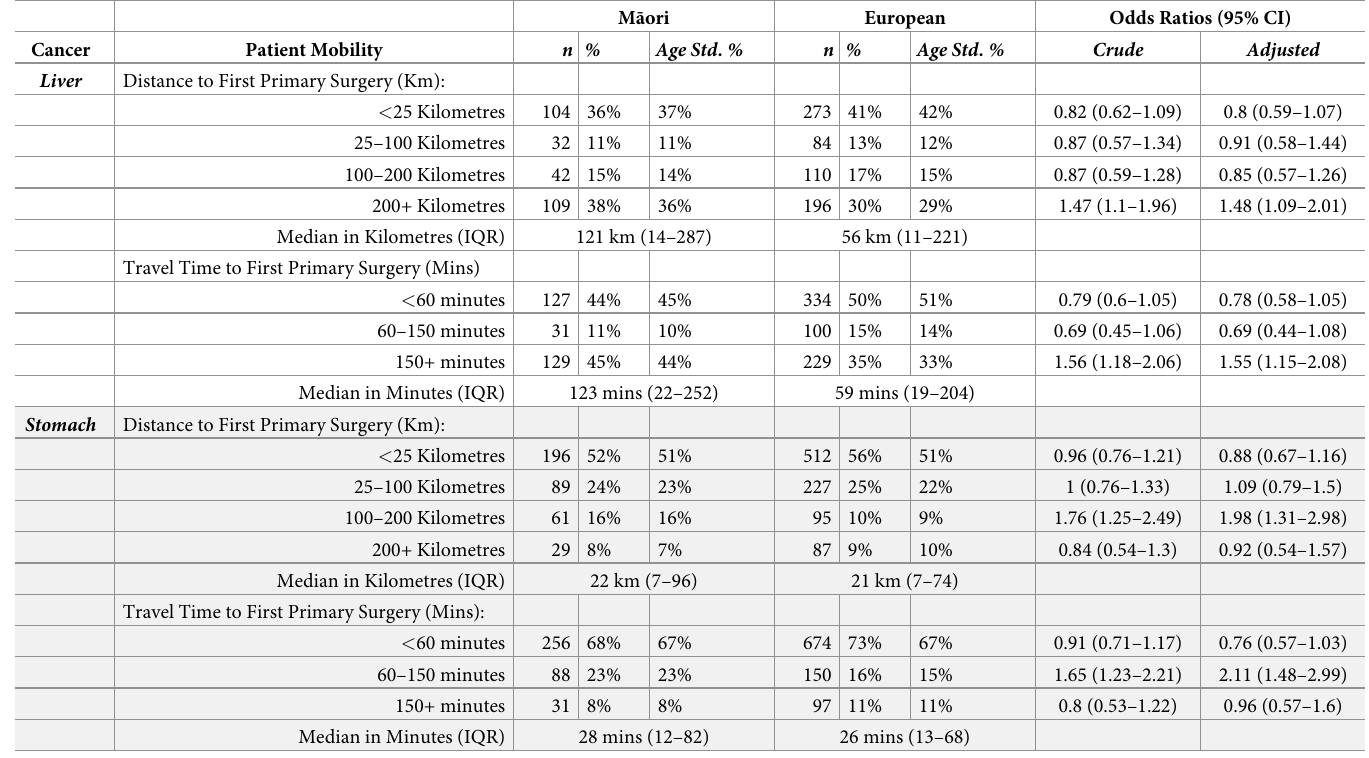
Table 2. Patient mobility to first primary surgery, in one-way distance and travel time, for M ā ori and non-M ā ori liver and stomach cancer patients.